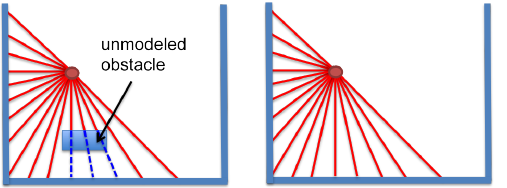
Figure 3. ( Left ) Unmodeled obstacle that generates an occlusion; ( Right ) laser estimate. Laser beams readin the known map and those not contained in the real observation vector in dashed